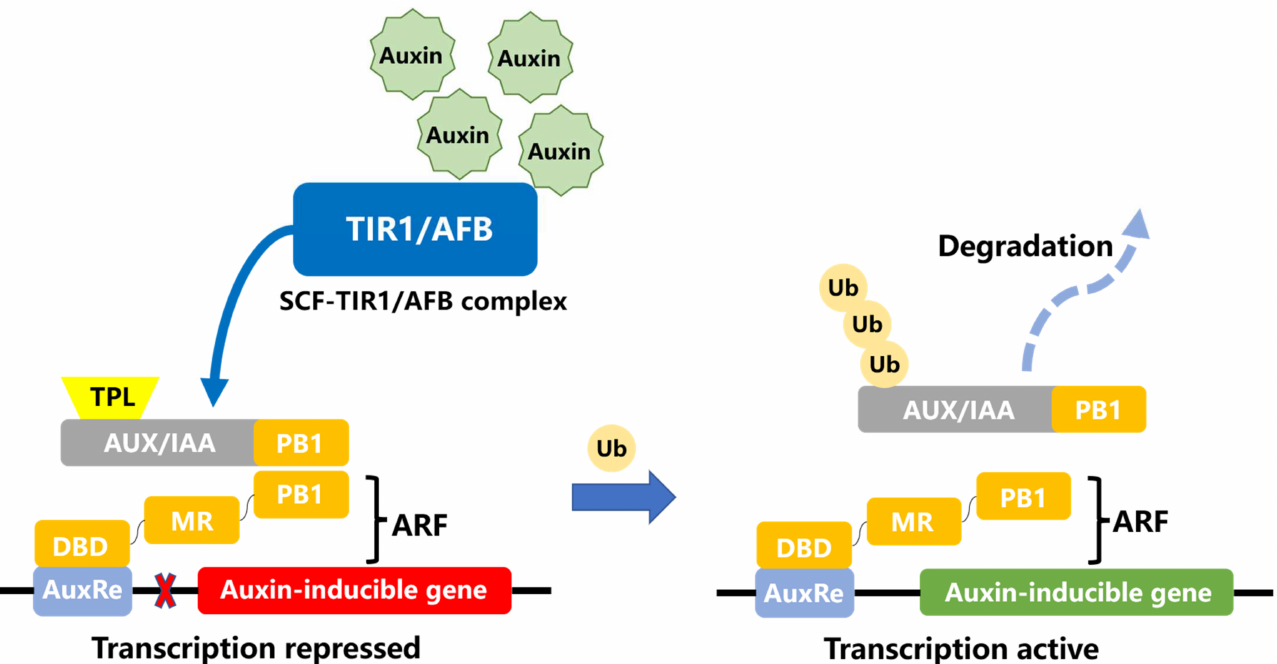
Figure 1. Model of ARF involvement in auxin response. The process of auxin signaling is coordinated by the auxin receptor TIR1/AFB, as well as the signal response factors AUX/IAA and ARF, which together mediate the auxin signaling response. Auxin acts as a “molecular glue” and facilitates the interaction between SCF-TIR1/AFB and Aux/IAA proteins. At low concentrations of auxin, the AUX/IAA repressor binds to the ARF transcription factor and forms a dimer that recruits the co-repressor TPL (TOPLESS) to inhibit the ARF activity and the expression of auxin responsive genes. When the concentration of auxin is increased, Aux/IAA binds to the SCF TIR1/AFB complex and is ubiquitinated and then degraded by 26S protease, and then ARF transcription factors are released to activate the transcription of downstream genes. DBD, DNA-binding domain; MR, middle region; PB1, Phox and Bem